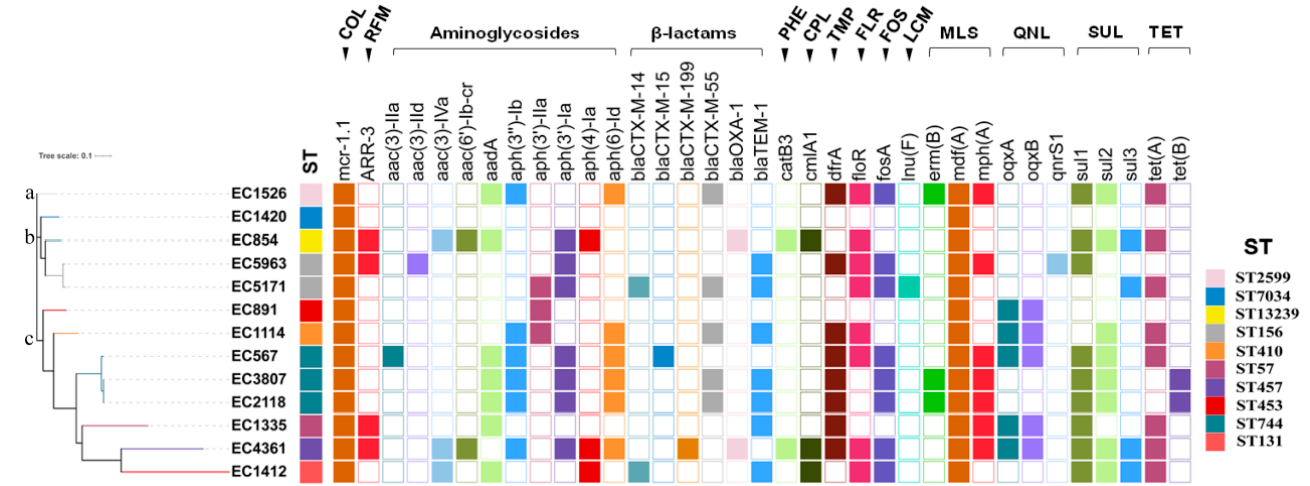
Figure 2. Phylogenetic relationship of the 13 MCREC isolates. The cell in different colour indicates the presence of the antimicrobial resistance gene while the blank cell indicates the absence of the gene. COL, colistin, RFM, rifamycin, PHE, phenicol, CPL, chloramphenicol, TMP, trimethoprim, FLR, florfenicol, FOS, fosfomycin, LCM, lincosamide, MLS, macrolides, QNL, quinolones, SUL, sulfonamides, TET, tetracyclines.